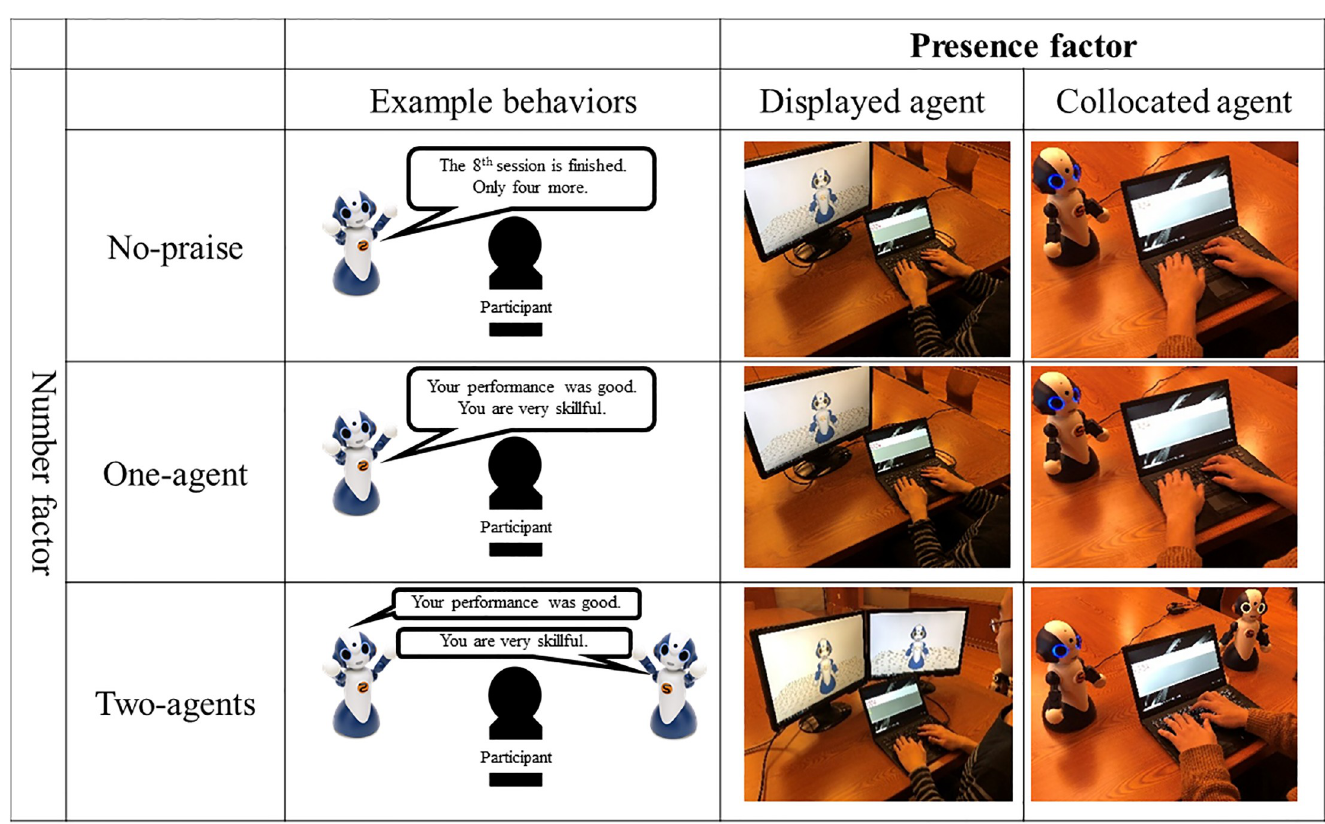
Fig 2. Experiment design: In no-praise group, one displayed/collocated agent explains task’s progress without any praise. In one-agent group, one displayed/ collocated agent gives praise during task. All praise contents include two sentences. In two-agent group, each agent gives one sentence of praise. Praise amounts are identical to one-agent